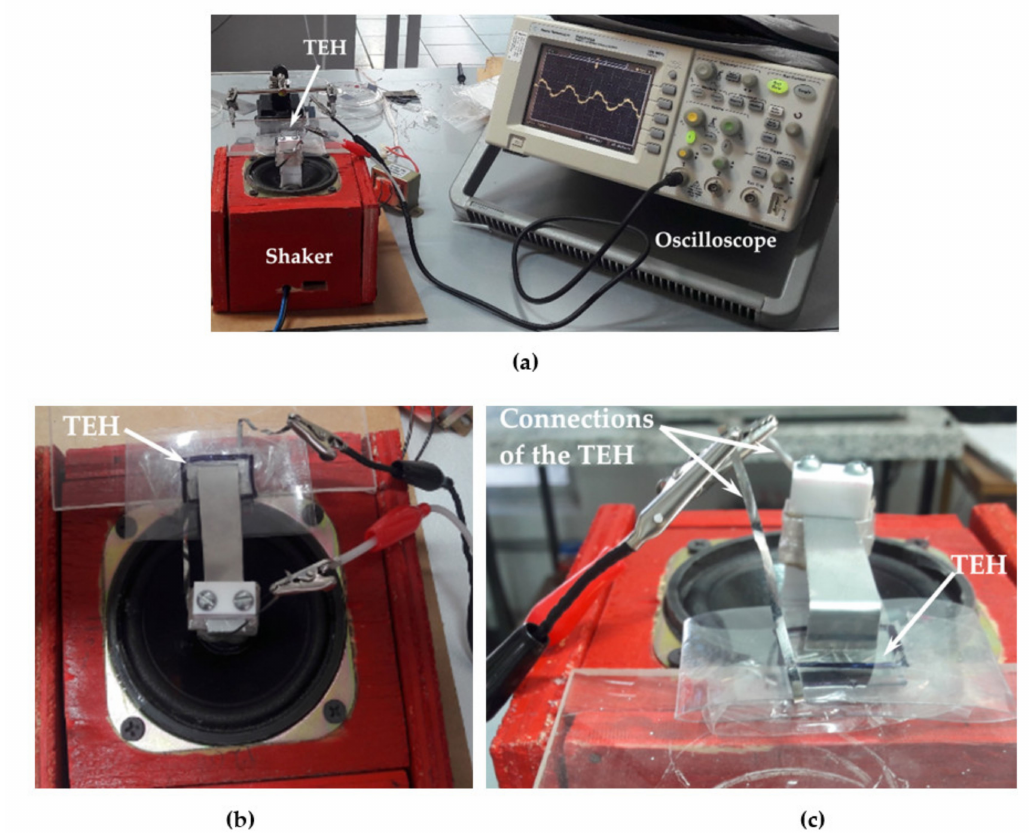
Figure 4. Experimental setup to measure the output voltage of the triboelectric energy harvester: ( a ) shaker, TEH and oscilloscope, ( b ) upper view of the TEH mounted on the shaker and ( c ) electrical connections of the